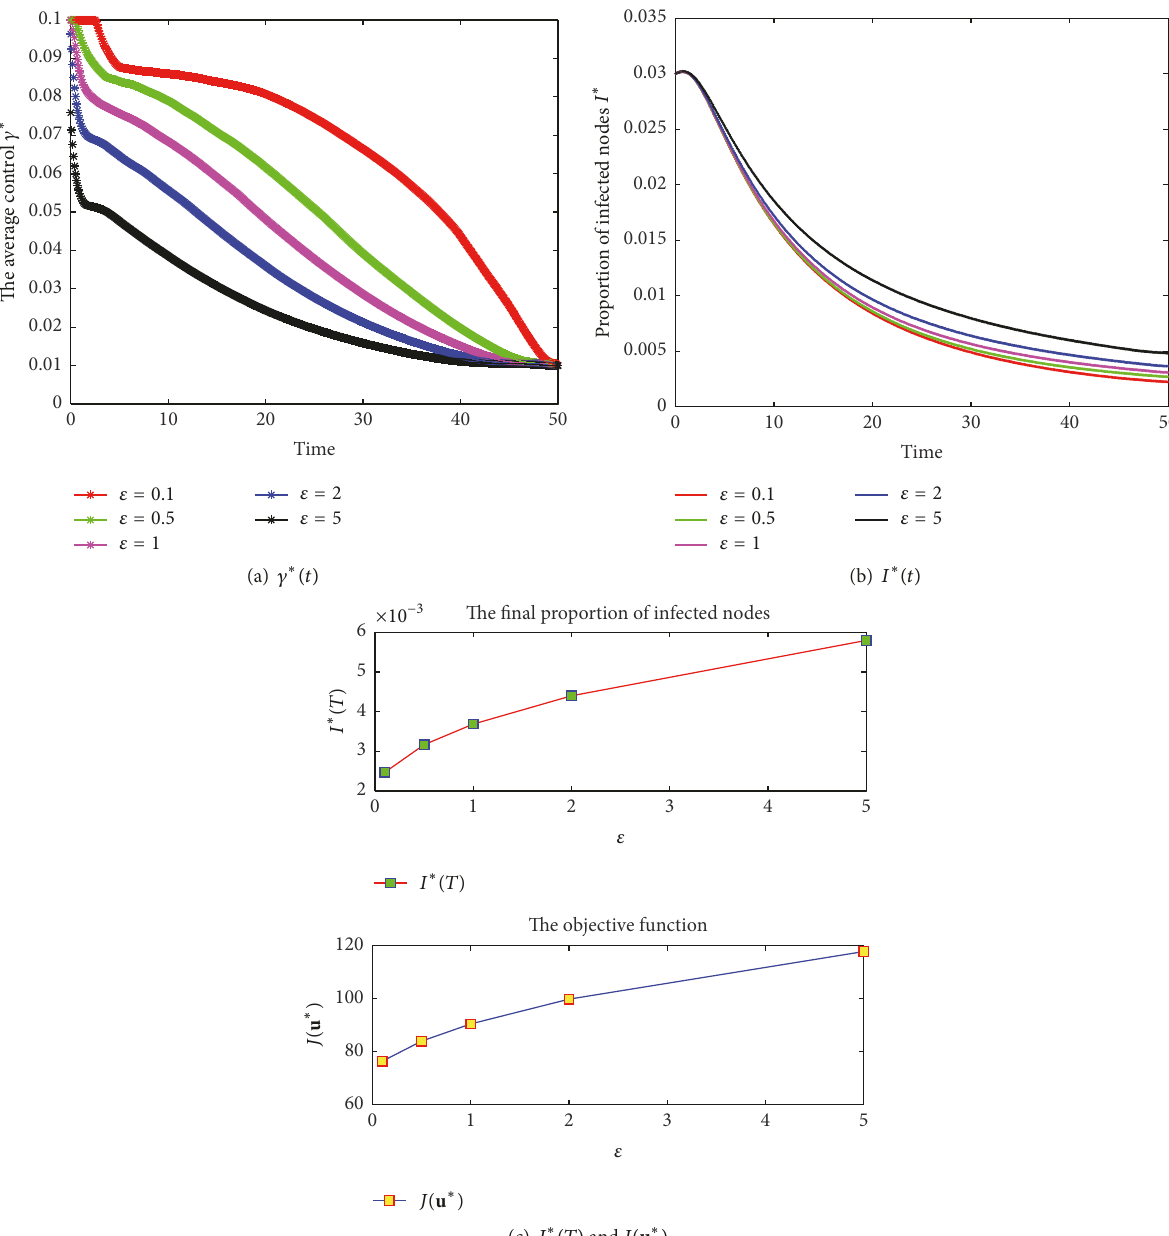
Figure 16: 𝛾 ∗ (𝑡) , 𝐼 ∗ (𝑡) , 𝐼 ∗ (𝑇) , and 𝐽( u ∗ ) for different 𝜀 with 𝑚 1 = 𝑚 2 = 5 for Example